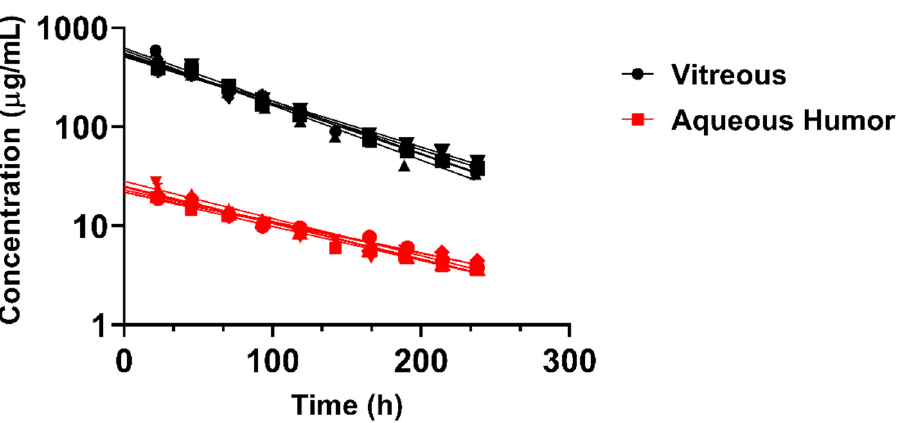
Figure 5. Concentrations of fluorescently labelled BDP-pullulan-DEX in the vitreous and aqueous humor of six rabbit eyes. Each line was fitted for the experimental data of one eye at different time points. One compartment model with first-order elimination rate constant was used for curve fit- ting.